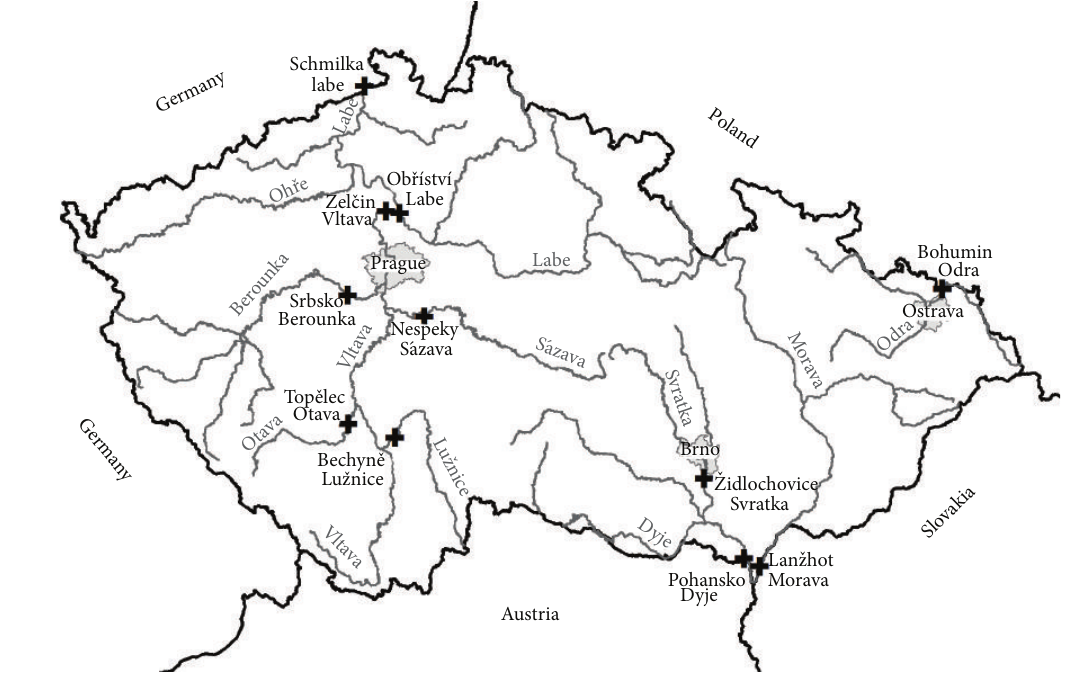
Figure 1: Study area in the Czech